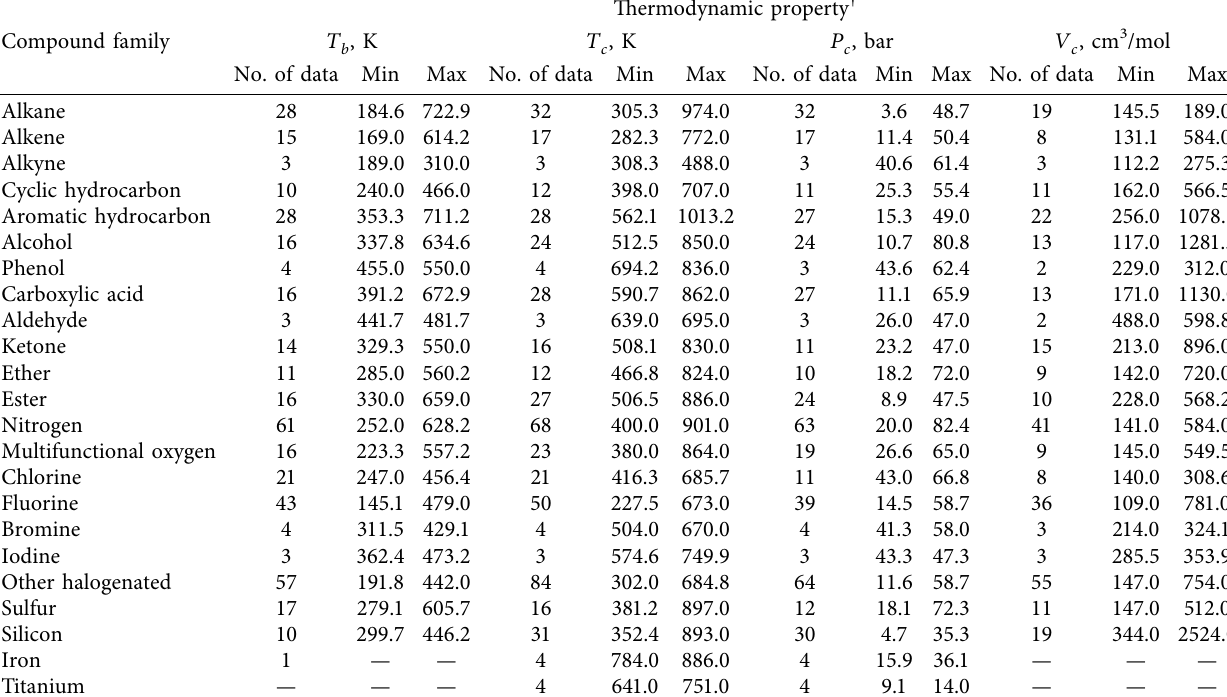
Table 1: Description of experimental database of thermodynamic properties used in this study. Compound